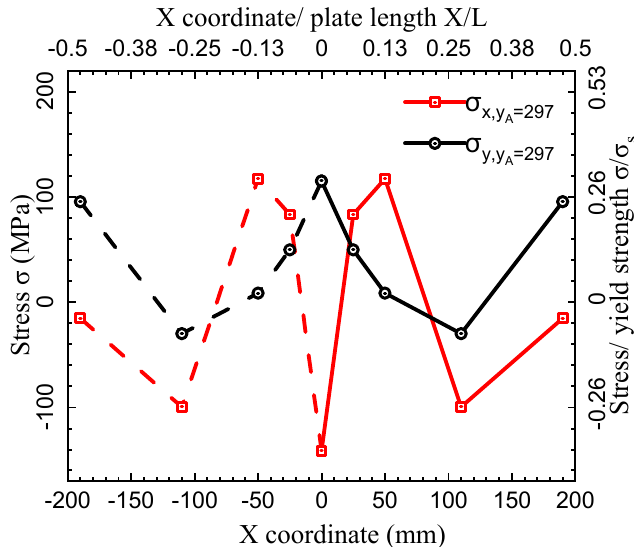
. (cid:3250) (cid:2880)(cid:2870)(cid:2877)(cid:2875)